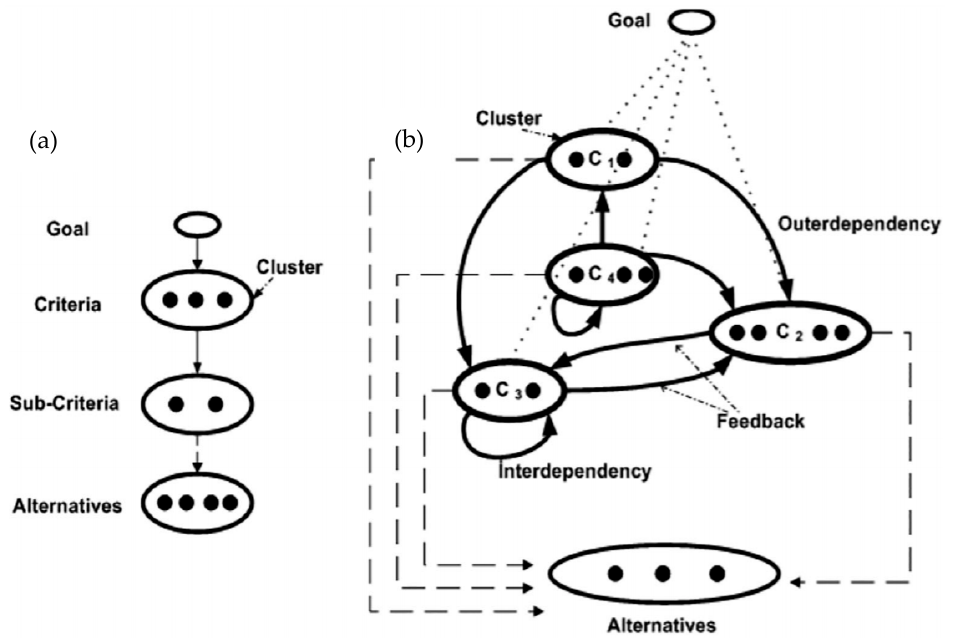
Figure 9. The general concept of AHP ( a ) and ANP ( b ) in the design selection process. Adapted with permission from Ref. [118]. Copyright 2020 Wiley.